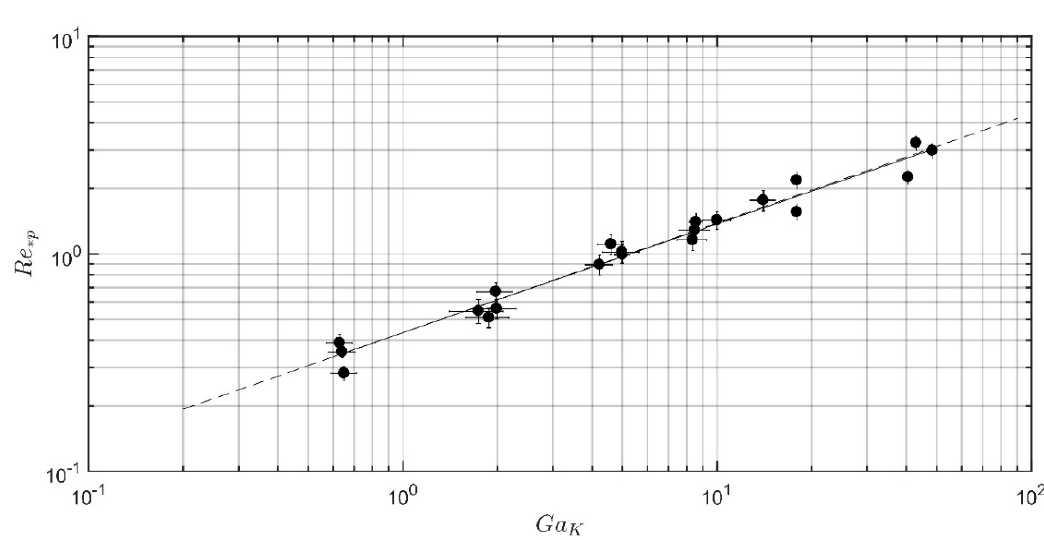
Figure 4. Condition of incipient motion in terms of the modified particle Reynolds number and the modified Galileo number. Continuous line corresponds to the best fit of the data. Segmented line is the relationship 𝑅𝑒 ∗(cid:3043) = 0.434(cid:3493)𝐺𝑎 (cid:3012) .